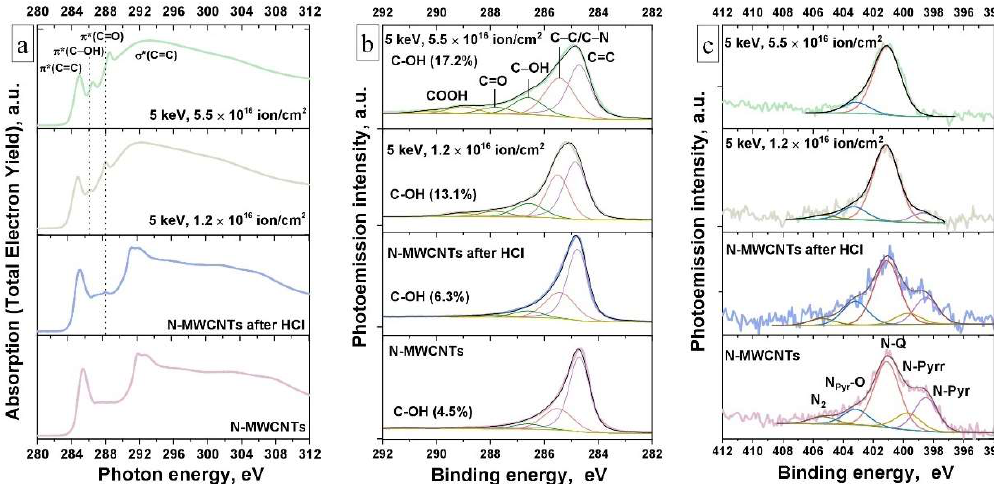
Figure 2. ( a ) C 1s NEXAFS spectra, ( b ) C1s (h ν = 400 eV) and ( c ) N1s (h ν = 500 eV) PE spectra of N-MWCNTs before and after treatments. Table 2. Five-component approximation for C 1s PE spectra.